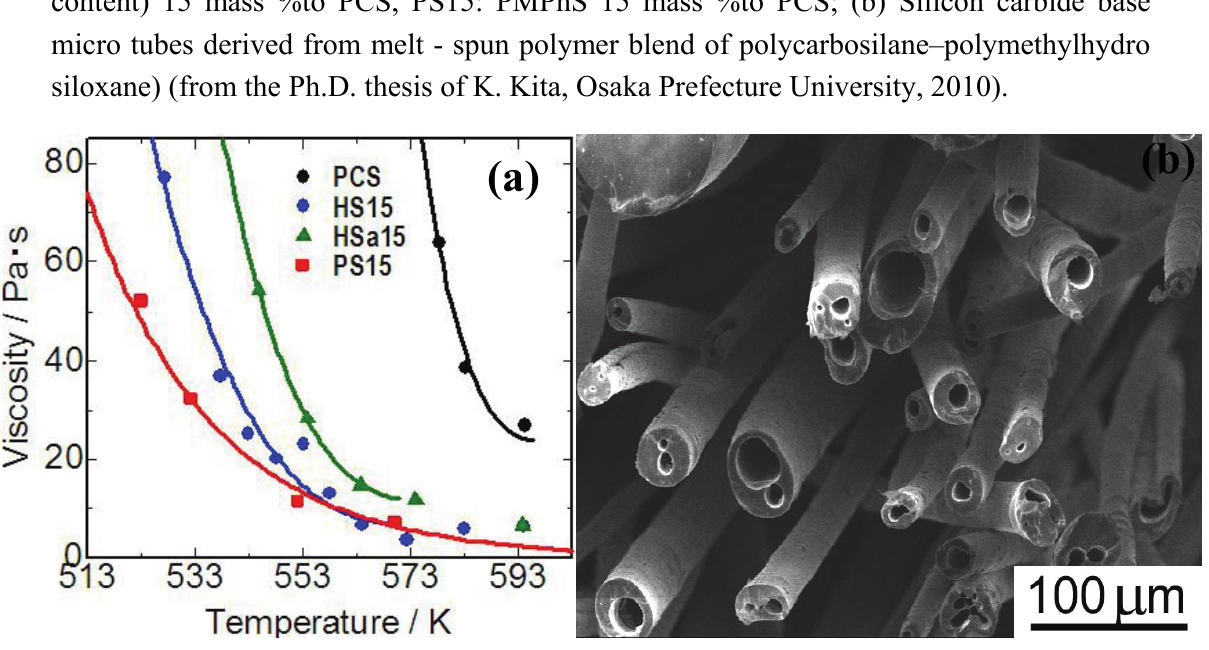
(a) Viscosity—temperature relationship of the polymer blends; PCS: polycarbosilane, HS15: PMHS 15 mass %to PCS, Hsa15: PMHSa (PMHS with low Si-H content) 15 mass %to PCS, PS15: PMPhS 15 mass %to PCS; (b) Silicon carbide